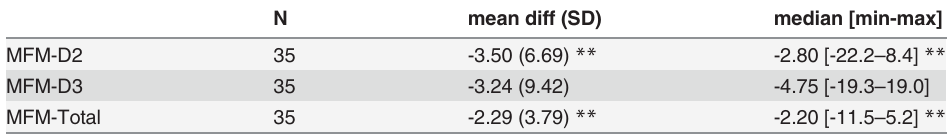
Table 7. Differences in MoviPlate scores on dominant and non-dominant sides in subjects grouped based on duration since loss of ambulation.